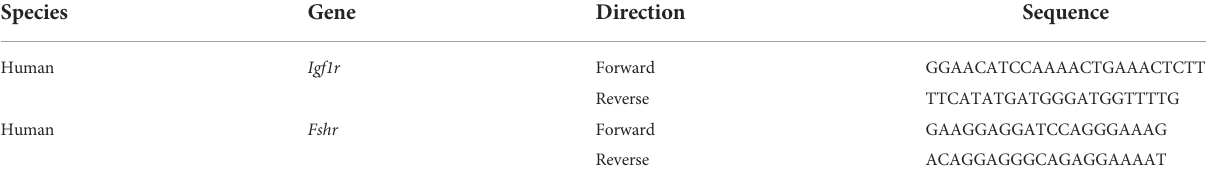
TABLE 2 Primer sequences for ChIP-qPCR.